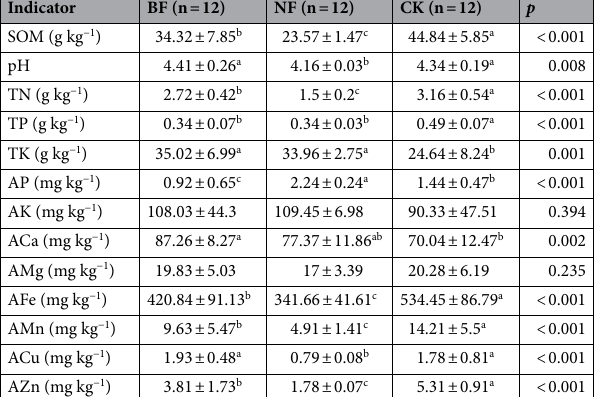
Table 2. ANOVA of the soil chemical properties of different slash disposal methods in GSDFF.